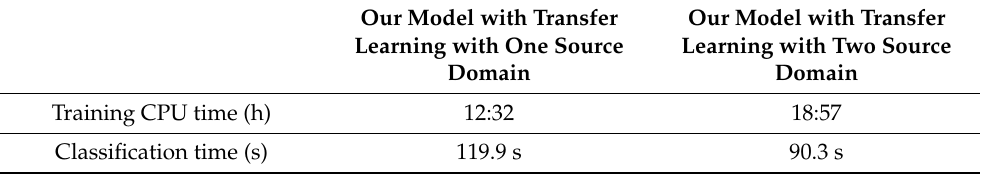
Table 11. Time complexity of the proposed model with and without transfer